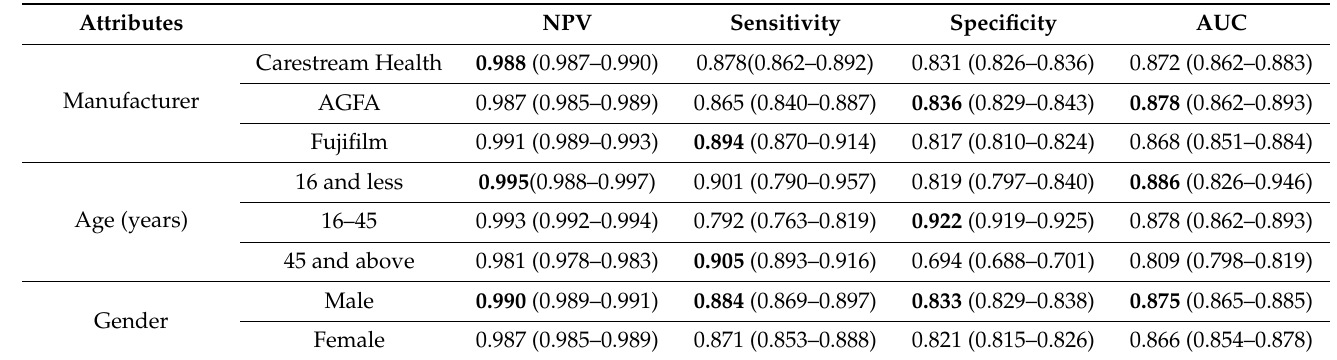
Table 2. Performance of qXR in categorizing normal or abnormal CXR stratified by patient’s demo- graphic and manufacturer using radiologist as reference standard. Negative predictive value (NPV); Area under the curve (AUC).